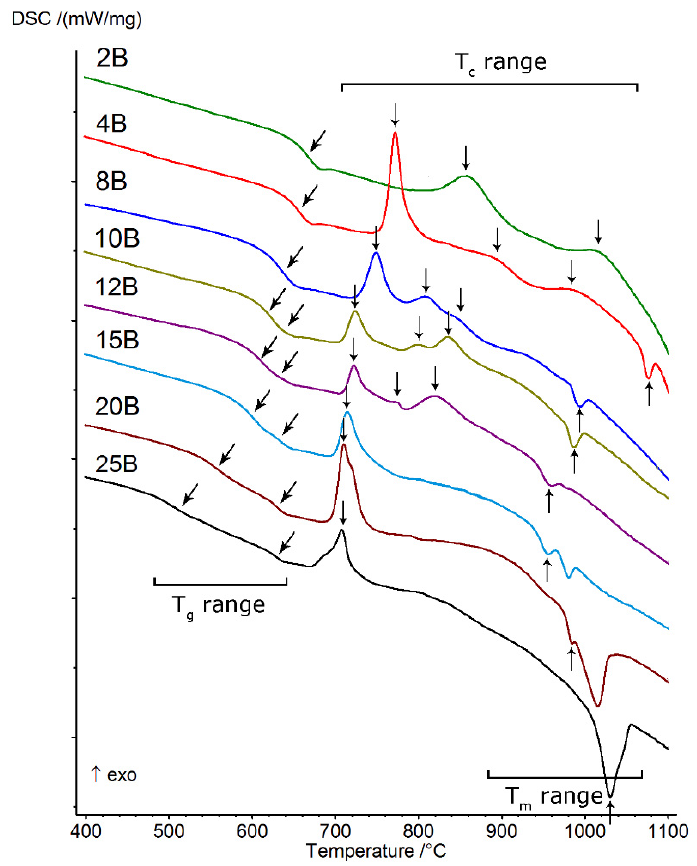
Figure 4. DSC curves of analyzed silicate–borate–phosphate glasses. Table 2. Thermal characteristics of the analyzed